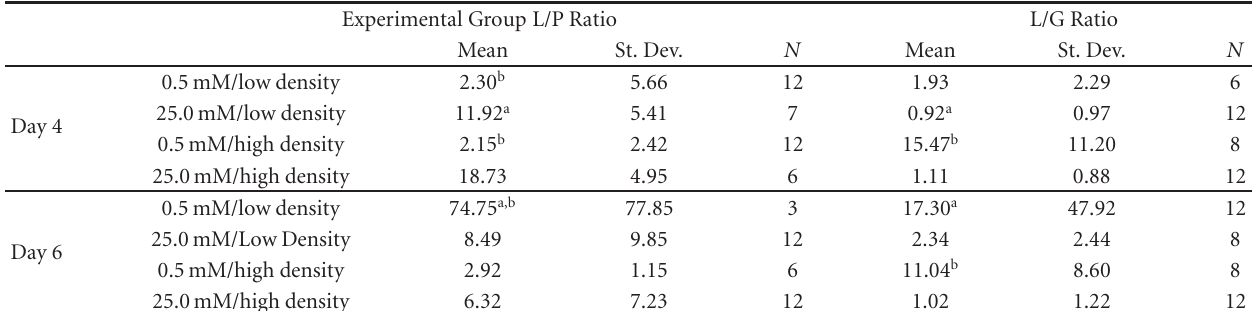
Table 2: Summary of three-dimensional metabolic ratios. There was no clear trend in the data. (a: significantly di ff erent from corresponding value in the 5.0mg/mL group; b: significantly di ff erent from the 25.0mM value within the same collagen group; P = . 05).